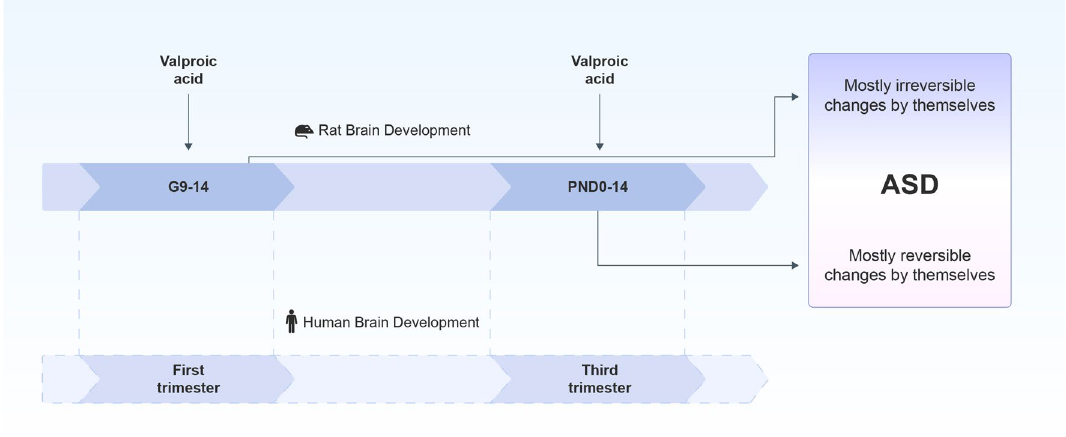
Figure 8. Possible ASD phenotypes modeled in rats by exposure to valproic acid in different periods of brain development in rodents and humans. Exposure to valproic acid on gestation day 12.5 of pregnant rat which corresponds to the 1st trimester of human pregnancy lead to manifestation of stable and irreversible ASD phenotype. While administration of valproic acid during the first two weeks of postnatal life, which corresponds to the 3rd trimester of human pregnancy, later is manifested with reversible ASD like symptoms. Mostly they appear at early adolescence and normalized up to adulthood by